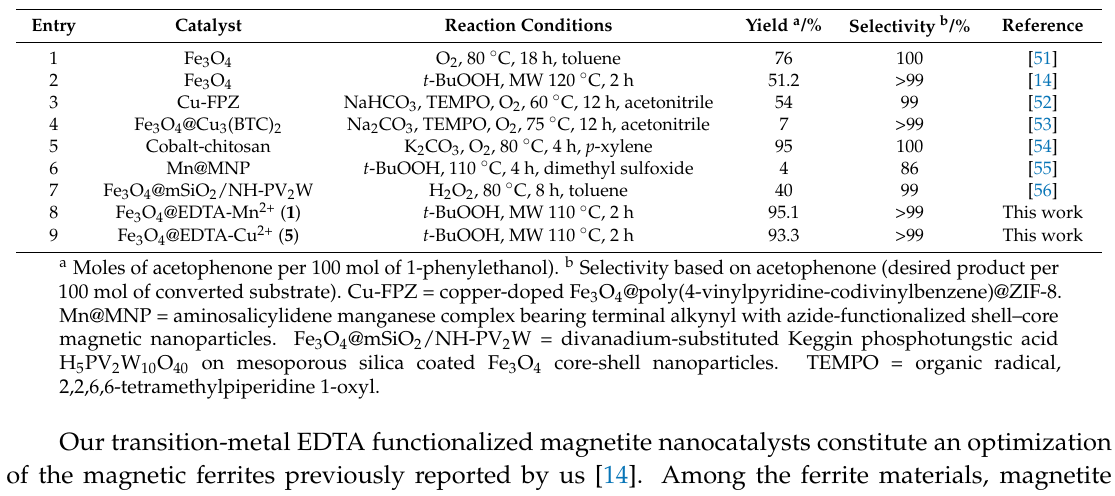
Table 3. Comparison of 1 and 5 MNPs with other magnetic-based first-row transition-metal catalysts for the oxidation of 1-phenylethanol to